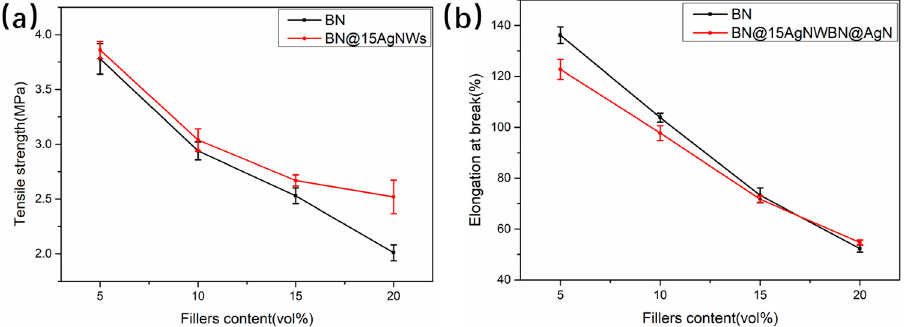
Figure 7. Tensile strengths ( a ) and elongation at break ( b ) of BN/PDMS and BN@15AgNWs/PDMS as a function of variant fillers contents.